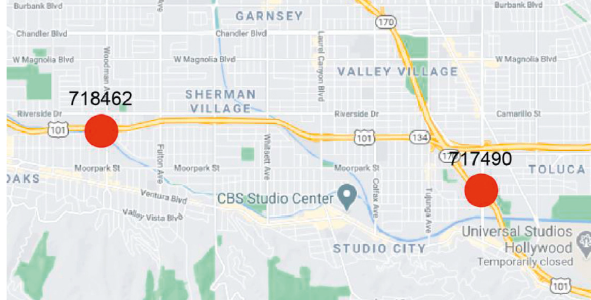
Figure 3: TCN residual block.